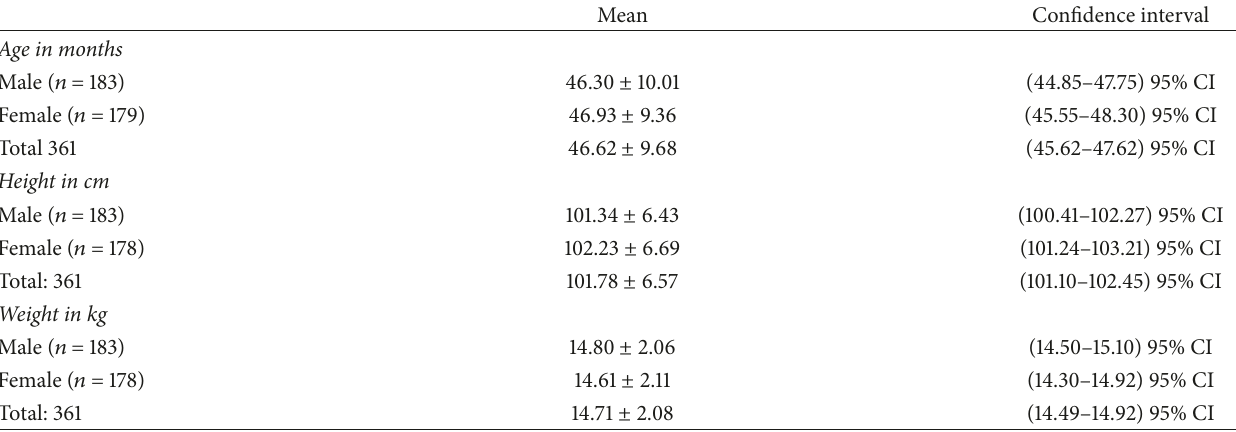
Table 1: Summary of anthropometric descriptive statistics of the sampled study population.